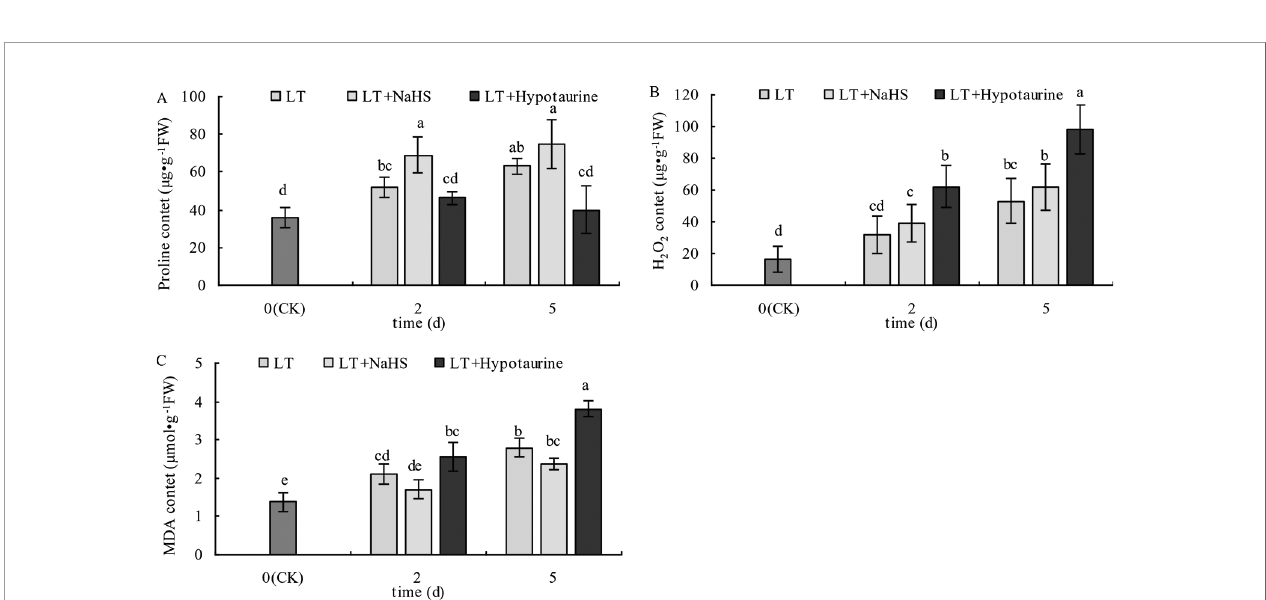
FIGURE 10 | Effects of exogenous NaHS and Hypotaurine on proline (Pro) (A) , H 2 O 2 (B) , and MDA (C) content in blueberry leaves under low temperature stress. The data in the fi gure are from three replicated experiments (n=3), and represent means ± standard error (SE). Different small letters show signi fi cant differences ( P < 0.05). CK: room temperature control at 25°C; LT: low temperature treatment; LT + NaHS: low temperature treatment at 4 – 6°C after spraying 0.5 mmol·L – 1 NaHS; LT + Hypotaurine: low temperature treatment at 4 – 6°C after spraying leaves with 200 m mol·L – 1